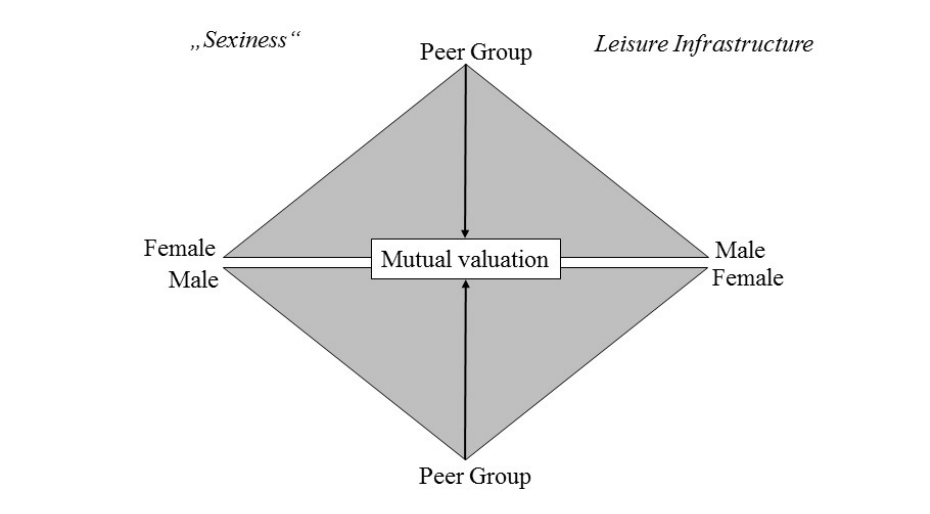
Figure 4 Modern heterosexual intimate valuation Source: Authors’ depiction based on Illouz